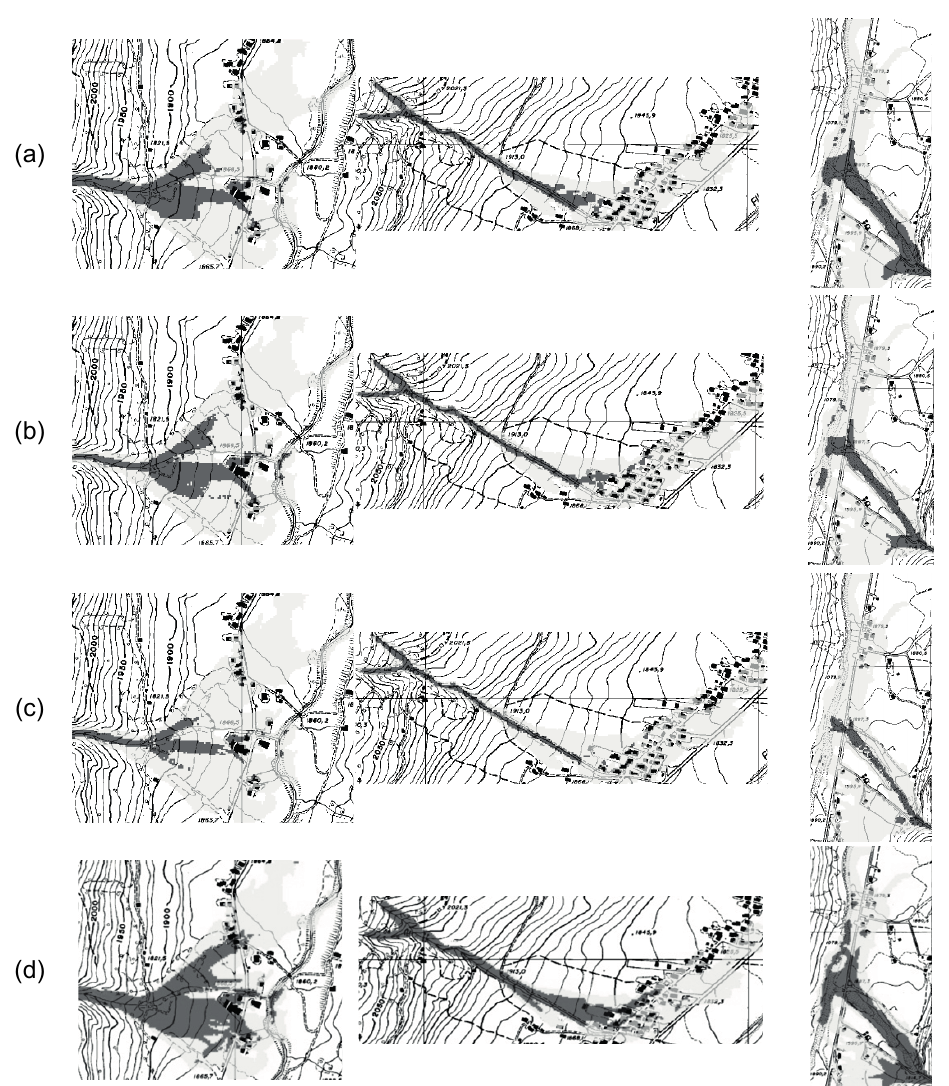
Fig. 5 Hazard criteria according to the Austrian (A), Swiss (B, just T = 100 year), Japanese (C) and human stability (D) methods. From left: basins 1, 2 and 3. Unscaled. Grey: high hazard; Light grey: medium hazard.